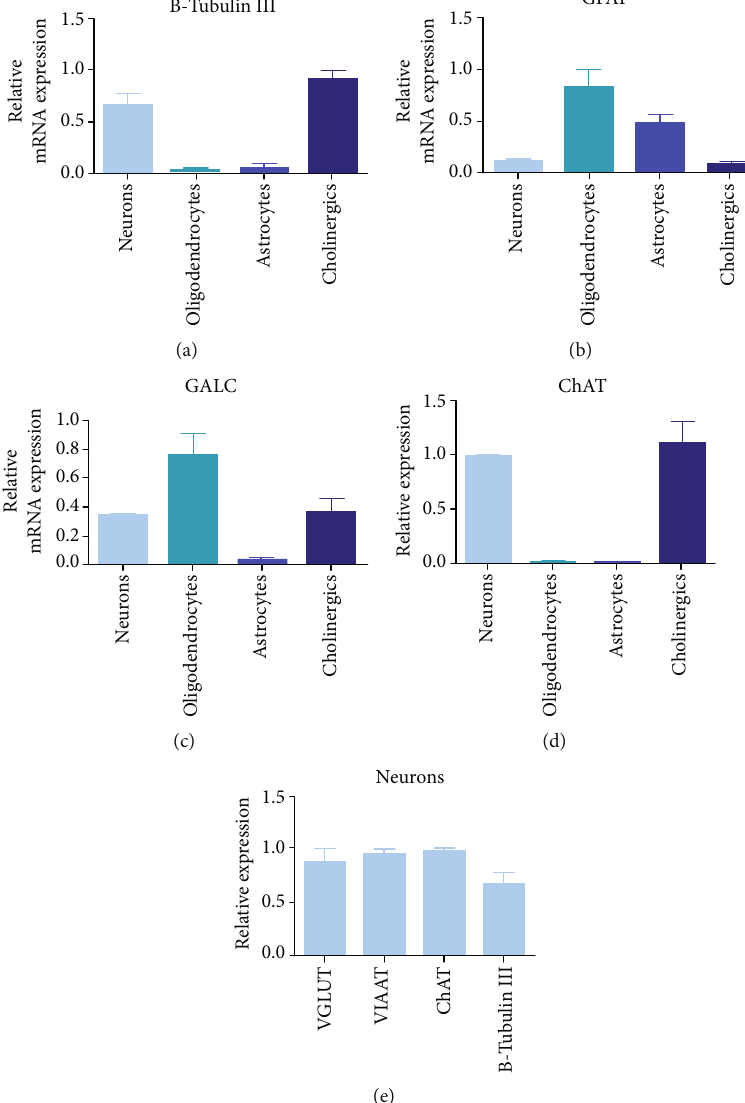
Figure 5: Terminal di ff erentiation cell cultures of neurons, oligodendrocytes, astrocytes, and cholinergic neurons were analyzed using qRT- PCR. In addition, the mixed neuronal cultures were analyzed for neuronal markers. Relative mRNA expressions of di ff erent targets were analyzed in the di ff erent cultures: (a) mean β -tubulin III expression in neurons 0 : 67 ± 0 : 11 , oligodendrocytes 0 : 041 ± 0 : 009 , astrocytes 0 : 04 ± 0 : 04 , and cholinergic 0 : 9 ± 0 : 08 ; (b) mean GFAP expression in neurons 0 : 12 ± 0 : 01 , oligodendrocytes 0 : 8 ± 0 : 1 , astrocytes 0 : 5 ± 0 : 07 , and cholinergic 0 : 01 ± 0 : 008 ; (c) mean GALC expression in neurons 0 : 3 ± 0 : 01 , oligodendrocytes 0 : 7 ± 0 : 1 , astrocytes 0 : 03 ± 0 : 01 , and cholinergic 0 : 3 ± 0 : 08 ; and (d) mean ChAT expression in neurons 0 : 98 ± 0 : 01 , oligodendrocytes 0 : 007 ± 0 , astrocytes 0 : 007 ± 0 , and cholinergic 1 : 06 ± 0 : 1 . (e) The neuronal culture was tested for several markers. mRNA expression of VGULT mean 0 : 89 ± 0 : 16 , VIAAT 0 : 96 ± 0 : 05 , ChAT 0 : 98 ± 0 : 02 , and β -tubulin III 0 : 67 ± 0 : 15 shows mixed culture of glutamatergic, GABA:ergic, and cholinergic neurons. Experiments were performed on two biological and three technical replicates of each lineage. Expression of each gene was normalized against RPL19